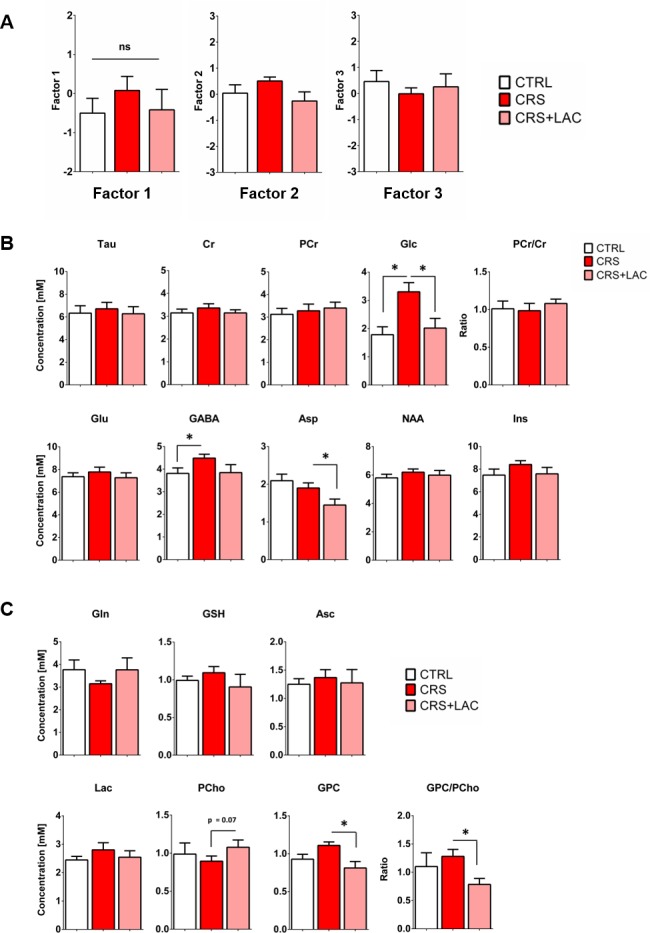
Effect of LAC on the accumbal neurochemical profile of low rank mice after CRS.(A) Factor analysis of the metabolic profile of nucleus accumbens of low rank mice after CRS. Factor one represents a linear combination that summarizes neurochemical changes including metabolites with strong (above 0.5: Tau, Cr, PCr, Glc, Glu, GABA, Asp, NAA and Ins.) and moderate (0.4–0.5: GSH and Asc) contribution in low rank mice (F2,15=0.54, p>0.05, one-way ANOVA; Fisher LSD test n = 6 per group). (B) Metabolites from Factor one with strong loading (above 0.5) Tau, Cr, PCr, Glc, Glu, GABA, Asp, NAA and Ins. The ratio of PCr/Cr is shown as well. One-way ANOVA followed by LSD Fisher post-hoc test, n = 5–6 per group. (C) Metabolites with moderate loadings (0.4–0.5) from Factor one and remaining metabolites from Factors two and three included Gln, GSH, Asc, PCho, Lac and GPC. The ratio of GPC/PCho was also reduced upon treatment. One-way ANOVA followed by LSD Fisher post-hoc test, *p<0.05, n = 5–6 per group. Overall, metabolite levels in low rank mice did not show substantial changes, except for Glc that was increased by CRS (p<0.05) and normalized by LAC treatment (p<0.05).